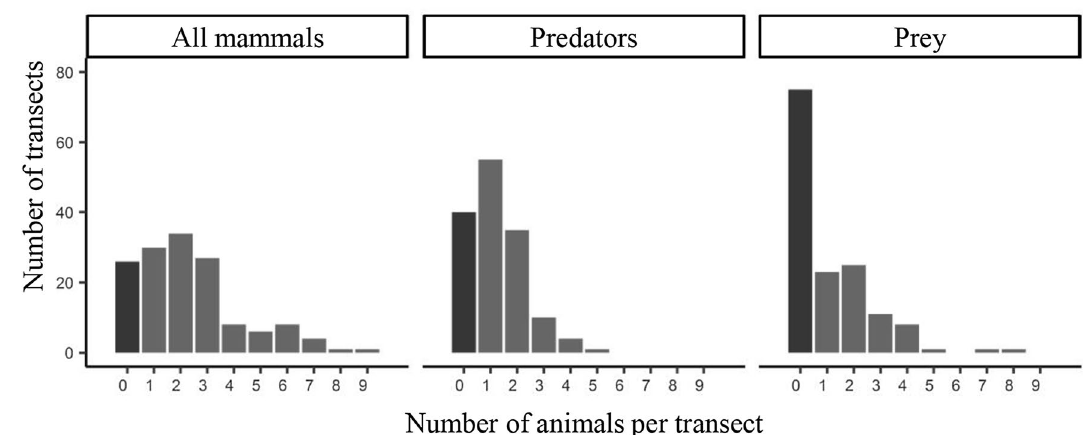
Figure 8. Number of transects with a given count of individuals per category of